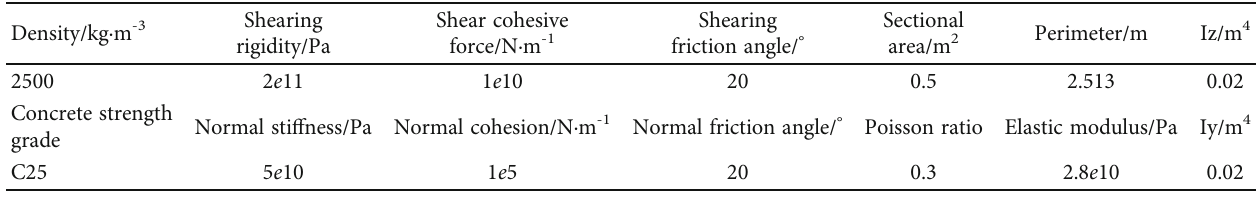
Table 6: Element parameters of slope protection piles.